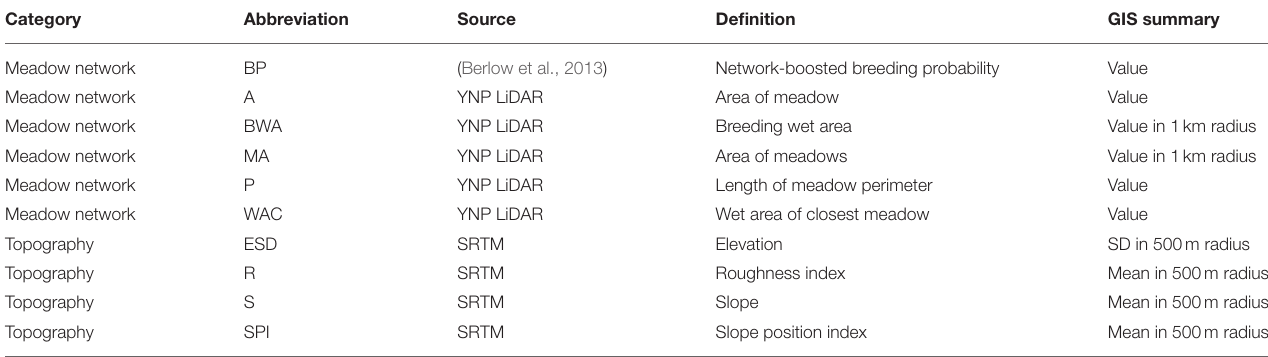
TABLE 1 | Hub-satellite predictive